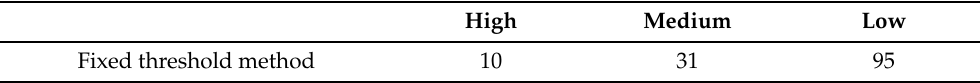
Table 7. Suspicion level of fixed threshold identification